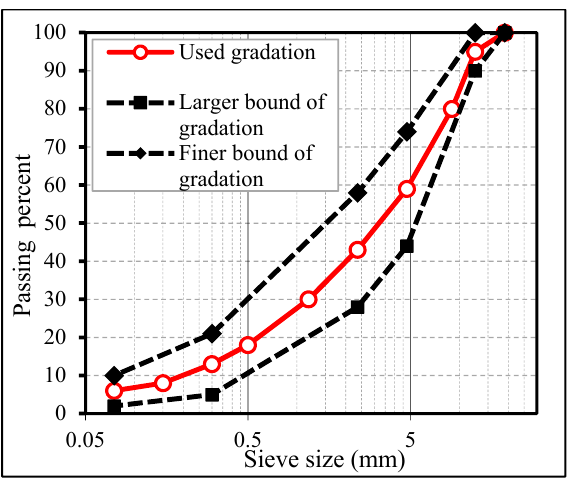
Figure 5. Aggregates gradations used in the current study for manufacturing asphalt mixture. Table 2. Characteristics of manufactured HMA